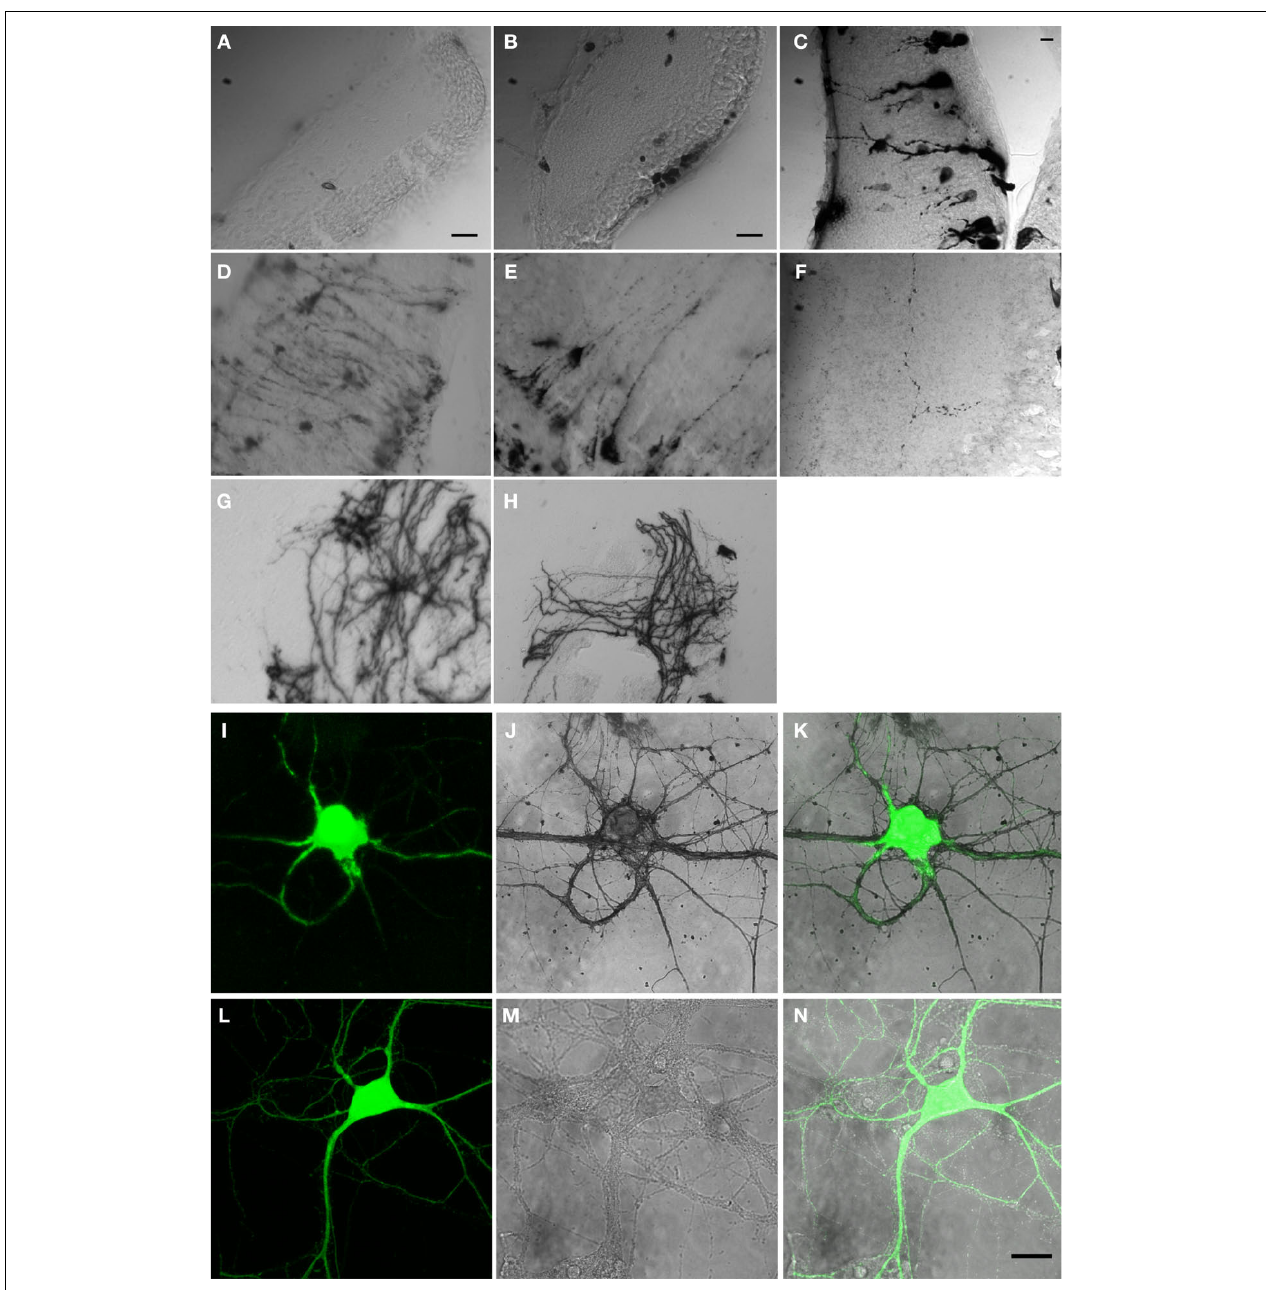
neurons. (I–K) A hippocampal neuron, transfected with EGFP/mHRP. (I) EGFP expression. (J) The mHRP was revealed by DAB reaction. (K) Merge of EGFP and DAB signal. (L,N) A hippocampal neuron, transfected with EGFP only, showed no DAB signal. (L) EGFP expression. (M) Image following DAB reaction. (N) Merge of EGFP and DAB signal. Scale bars in (A) and (B) are 20 µm. Scale bar in (C) is 10 µm and applies to (D–H) . Scale bar in (N) is 20